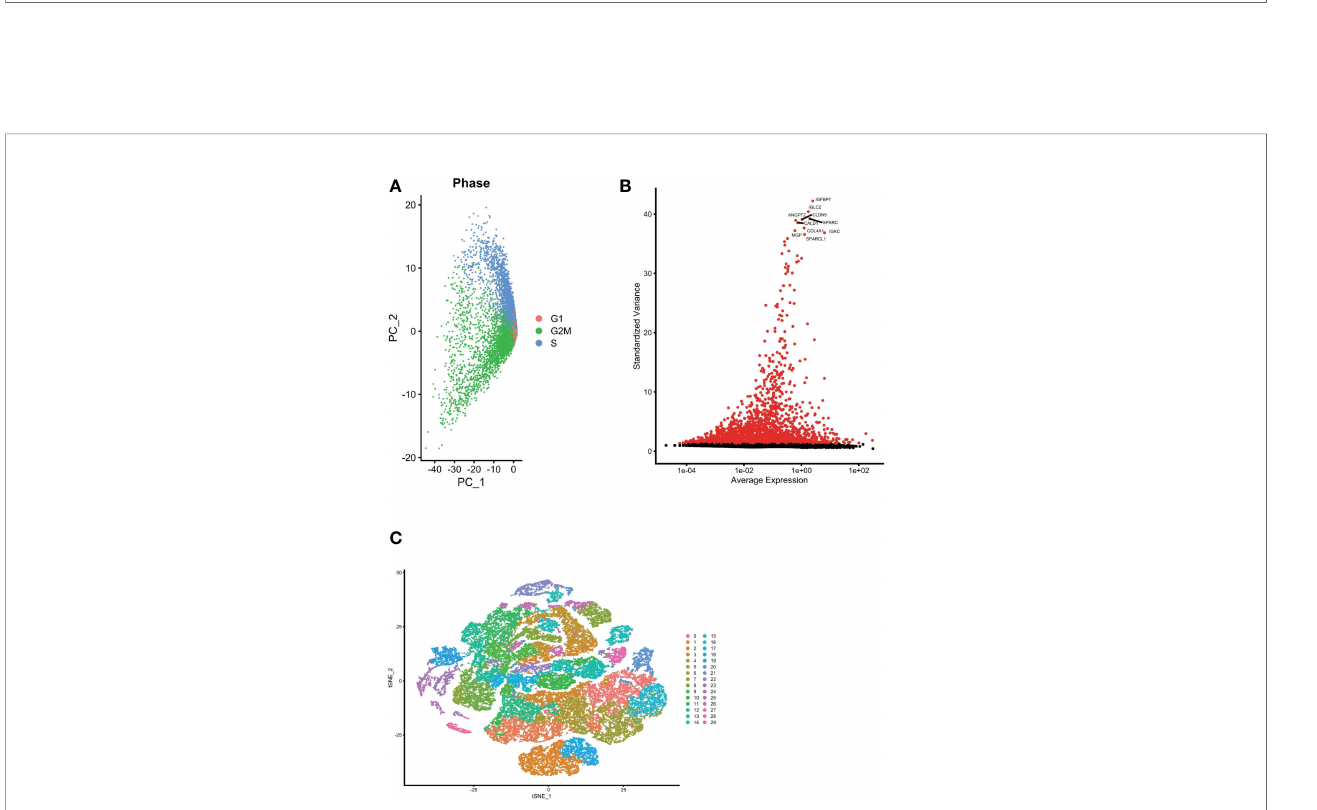
FIGURE 7 | Single cell sequencing analysis was performed to reduce the dimensionality of glioma cells. (A) PCA reduction plot showed no signi fi cant differences in cell cycles. (B) The top 3000 variable features were labeled in red. (C) Dimensionality reduction and cluster analysis. The principle component analysis showed the distribution of the samples, and the results showed no signi fi cant batch